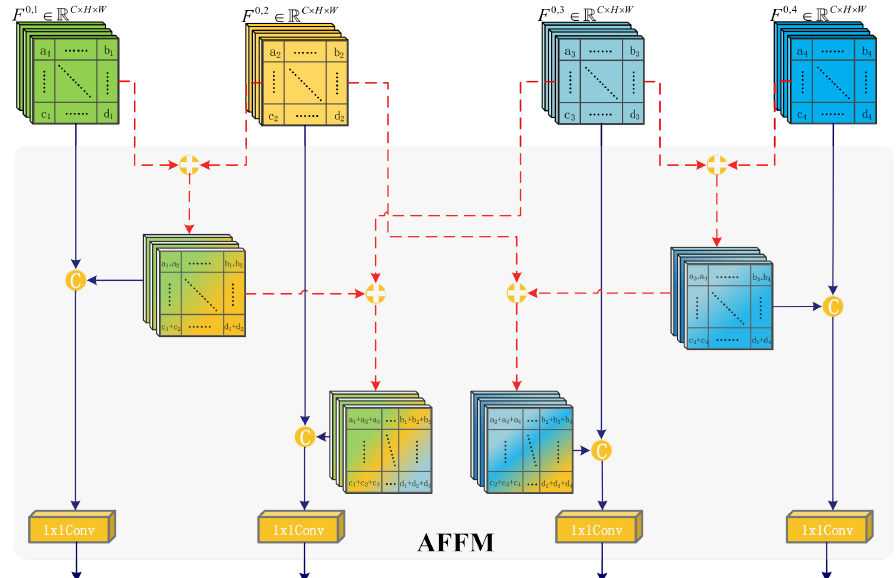
Figure 2. Architecture of Adjacent Feature Fusion Module